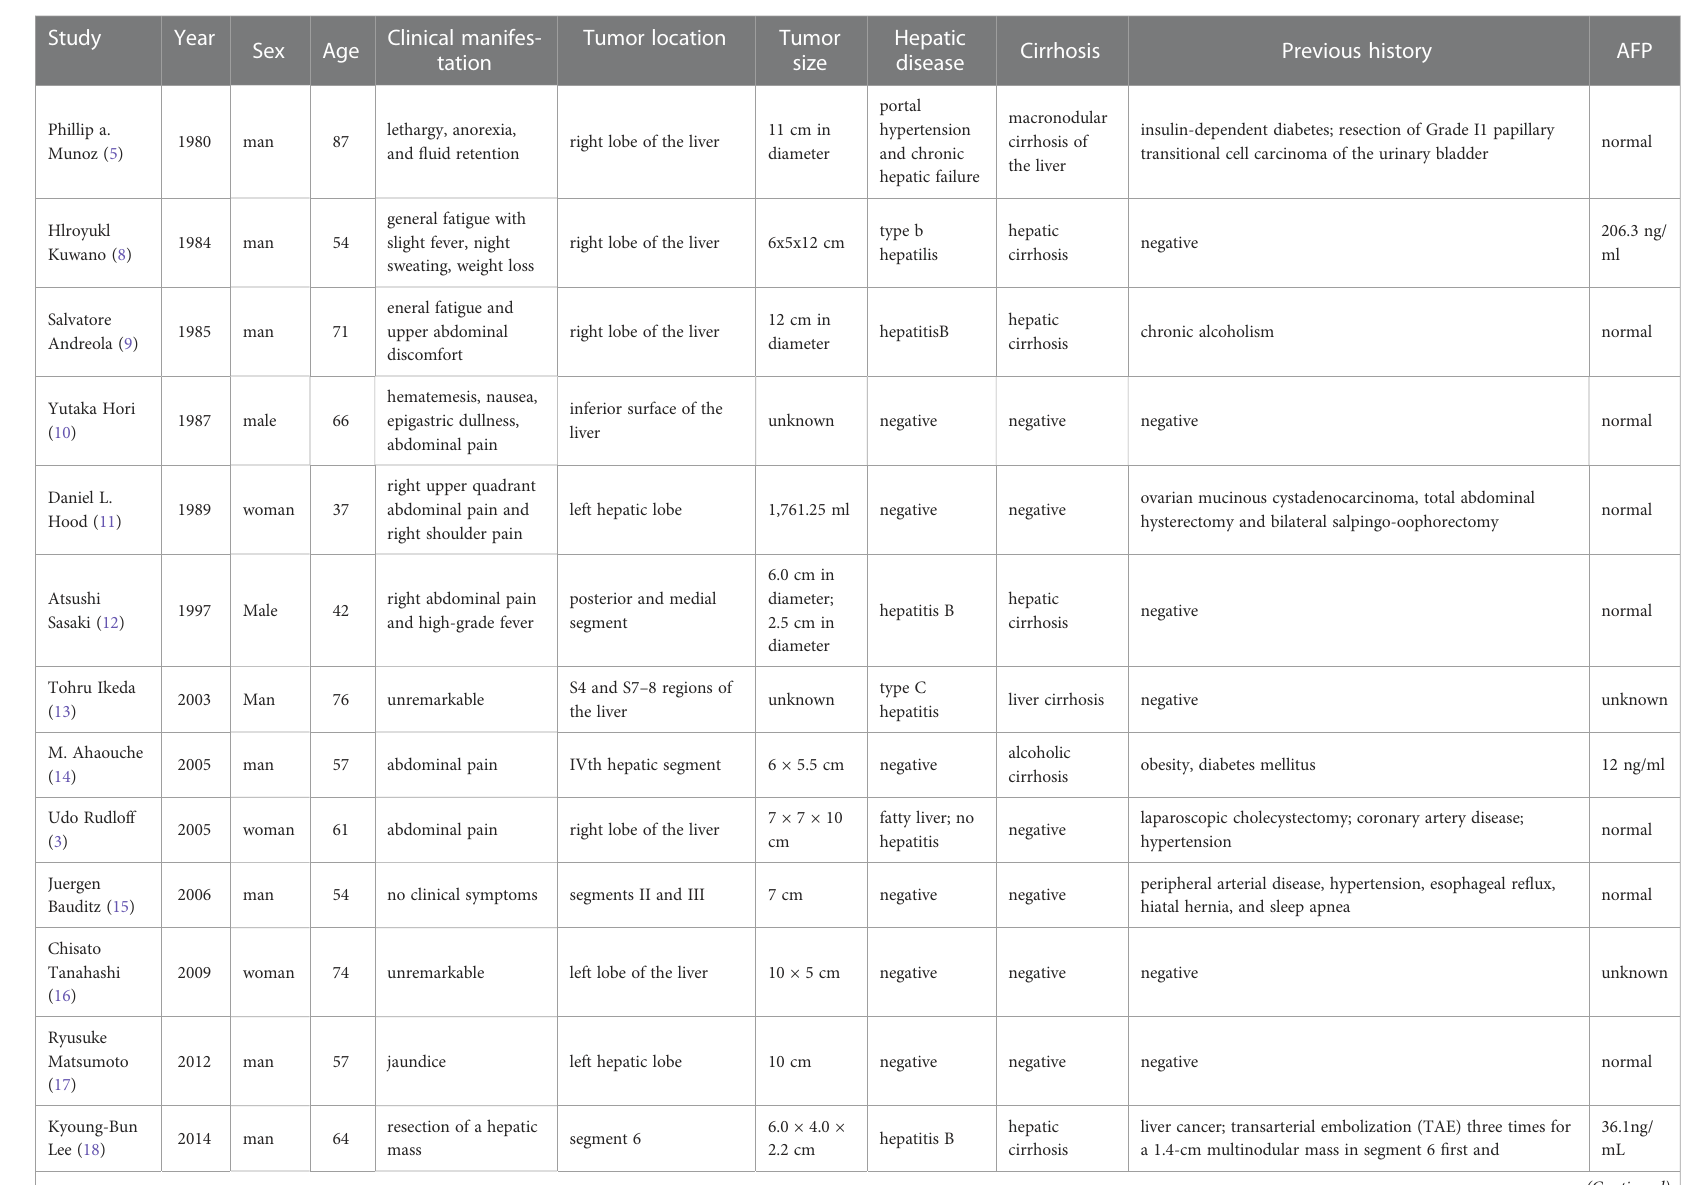
TABLE 2 Clinical manifestation of hepatic tumor with